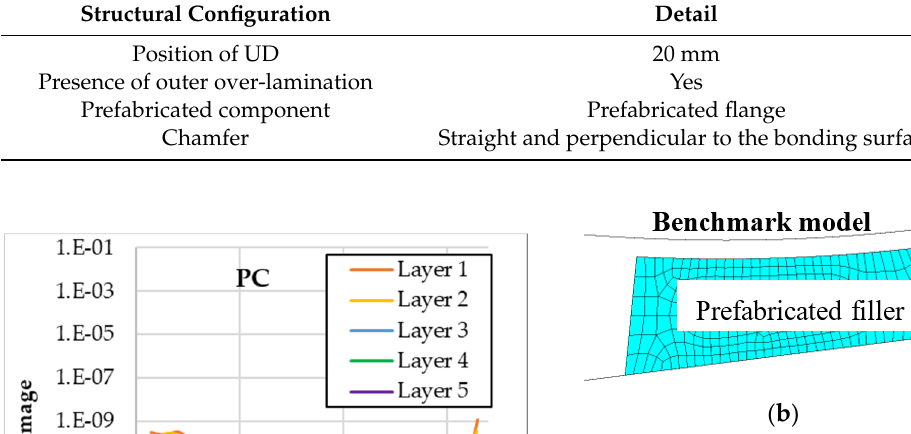
Table 3. Structural configurations of PC model.